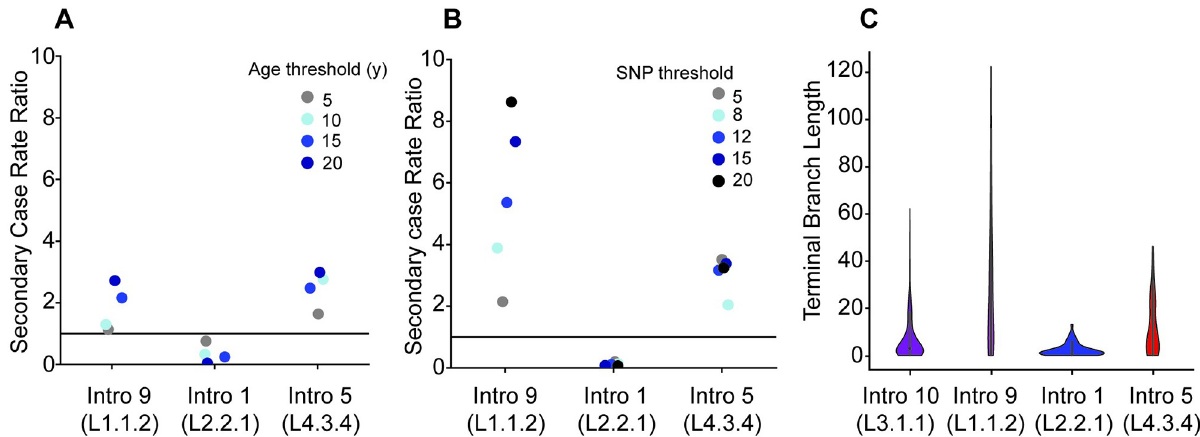
Fig 4. Transmission analysis using three different approaches. A and B compare the secondary case rate ratios between Introduction 10 of L3.1.1 and the other successful introductions identified determined based on clustering by using different age thresholds (in years) or different SNP thresholds for A or B, respectively. A secondary case rate ratio of 1 (indicated by a horizontal line) would mean that the secondary case rates of both introductions are the same. C Violin plots comparing the terminal branch lengths between the most successful